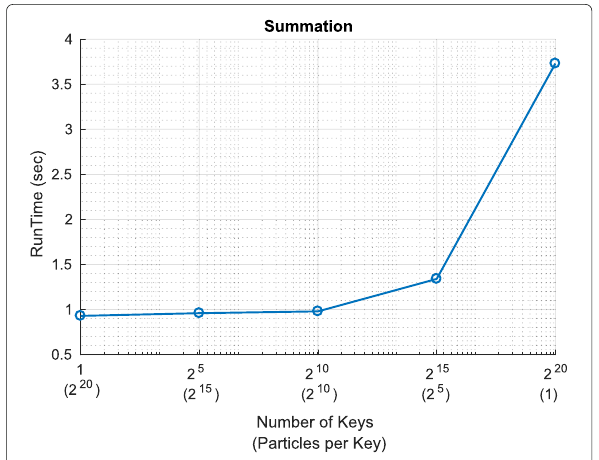
Fig. 18 Performance of summation using Spark with a fixed total number of values comprised of different number of keys and therefore different numbers of values per